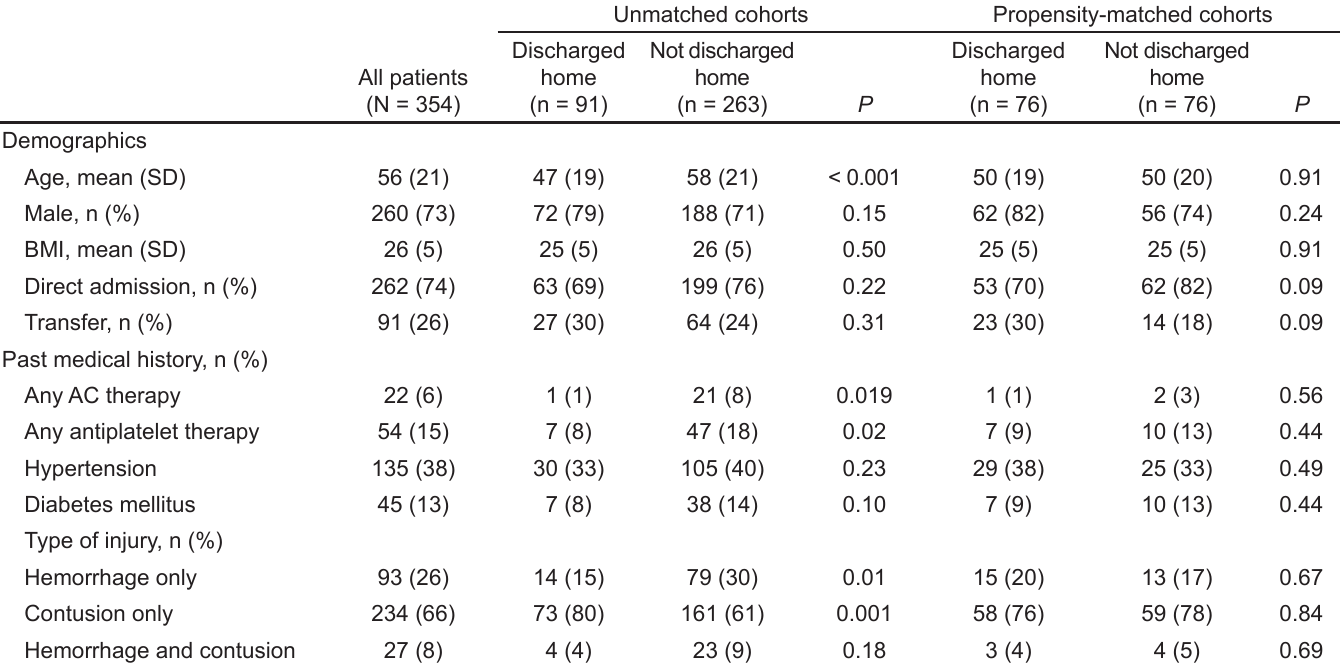
Table 1. Characteristics of 354 patients with traumatic intraparenchymal contusion or hemorrhage by discharge location, matched and unmatched